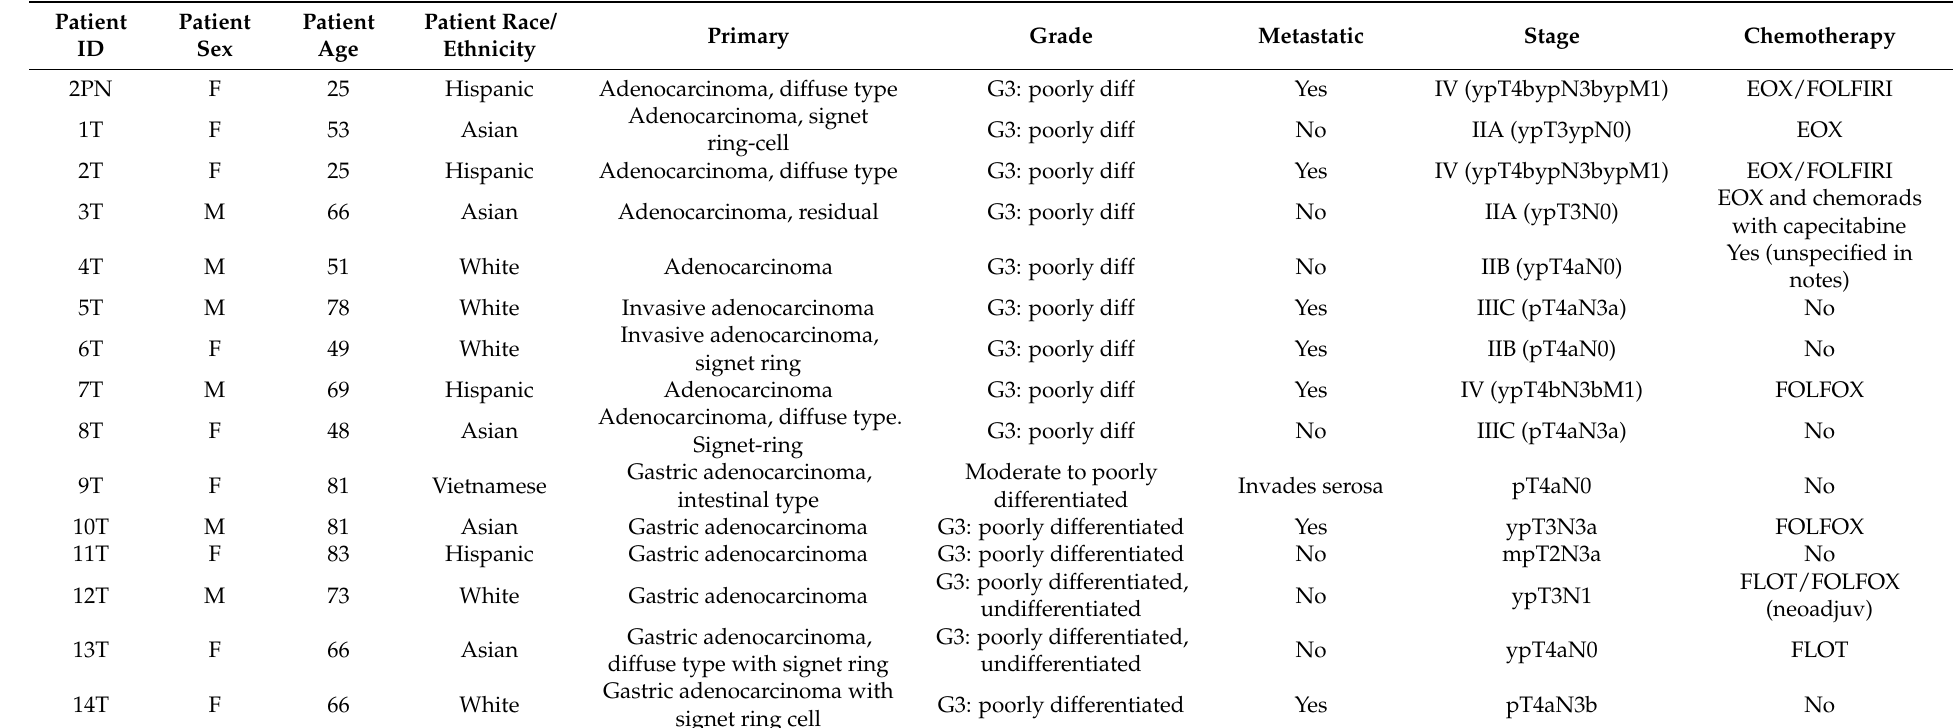
Table 1. Characteristics of gastric cancer